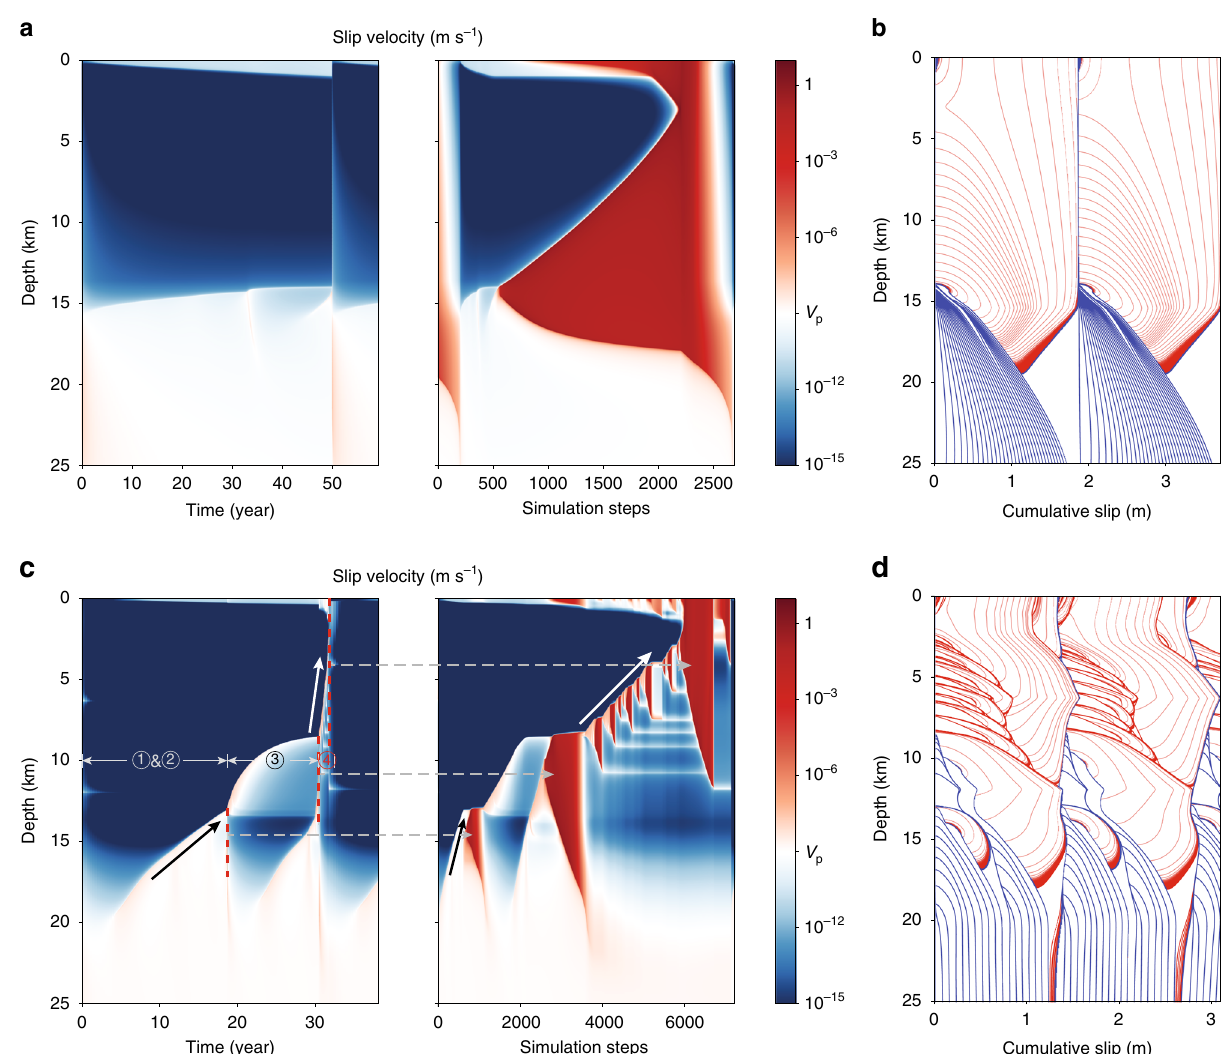
Fig. 2 Evolution of slip velocity and slip. a , b Reference model; c , d fault valving model. Slip contours in b , d are plotted in the coseismic period in red every 1 s and in interseismic period in blue every 1.5 years. In the fault valving model, fl uid-driven aseismic slip fronts (with accompanying overpressure, Fig. 3a, b) emerge from the base of the seismogenic zone (e.g., black arrow), migrating upward and nucleating earthquakes. The continued ascent of the overpressure pulse triggers swarm seismicity in the mid-seismogenic zone (white arrow, also Fig. 4). Slip at Earth ’ s surface that accompanies deeper seismic events is an artifact of the quasi-dynamic elastic approximation and should be